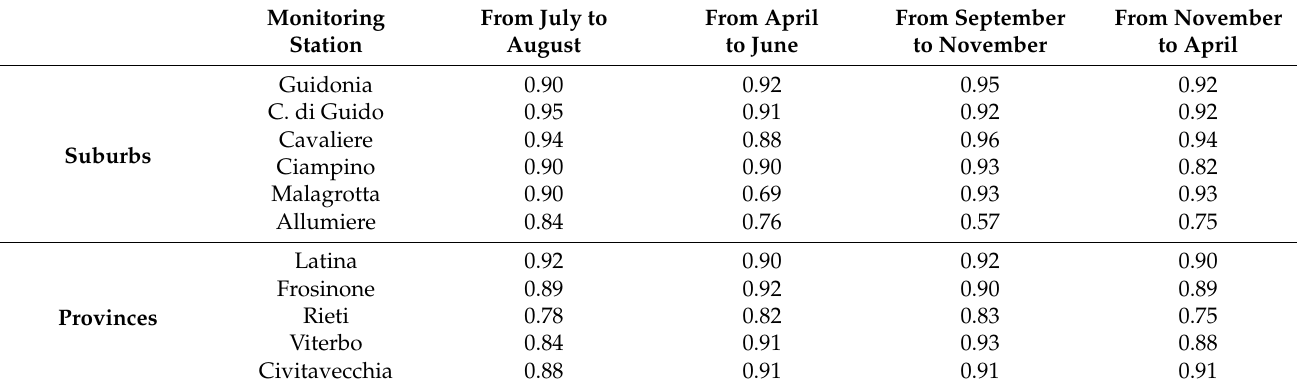
Table 11. Cross-correlation values between Roma Green Band and suburbs or province stations of [PM 10 ] in 2015.